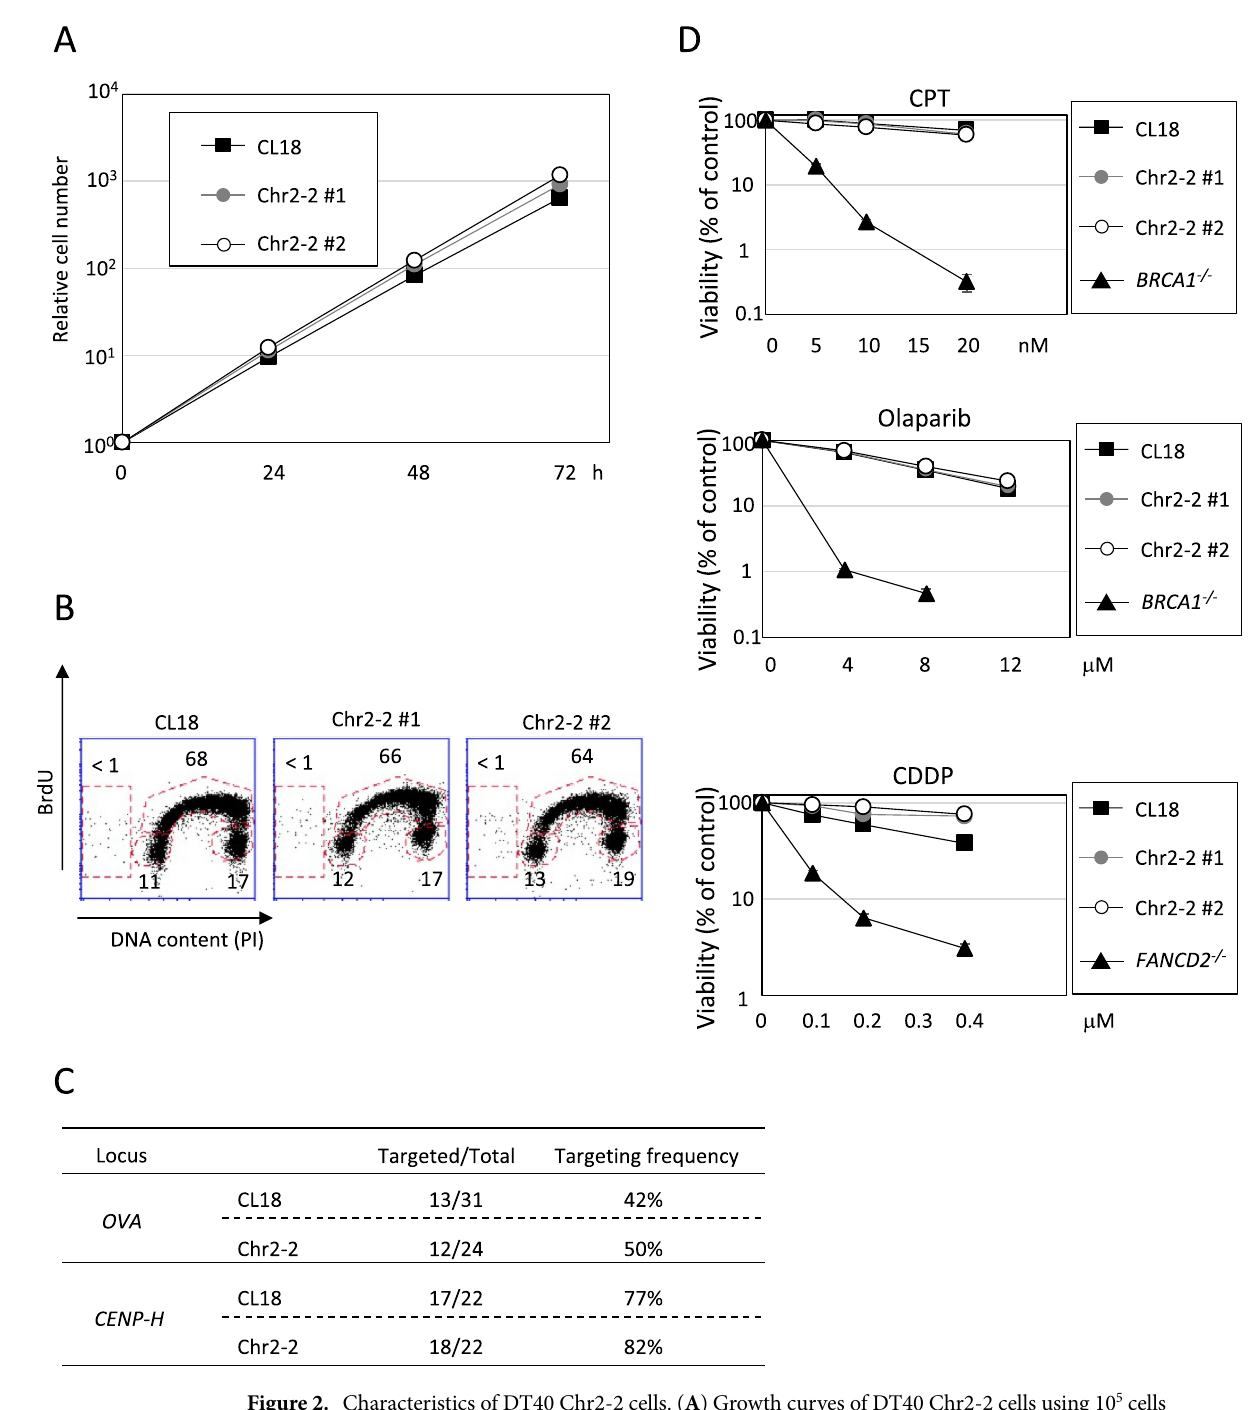
Figure 2. Characteristics of DT40 Chr2-2 cells. ( A ) Growth curves of DT40 Chr2-2 cells using 10 5 cells inoculated in 1 mL of medium. Cell number was counted and passaged every 24 h. ( B ) Cell cycle distribution of DT40 Chr2-2 cells. Cells were pulse-labeled with BrdU for 15 min, harvested, and then incubated with anti- BrdU antibody. The cells were stained with Alexa488-conjugated anti-Mouse IgG co-stained with PI for the detection of DNA content. ( C ) Targeting frequency of DT40 CL18 and Chr2-2 cells. Cells were transfected with targeting constructs of the indicated loci. Targeting frequency was calculated by targeted over analyzed clone numbers. ( D ) Cellular sensitivity against DNA damaging agents. The indicated genotype cells were exposed to CPT (top), Olaparib (middle), or CDDP (bottom). The dose of the genotoxic agent is displayed on the x-axis on a linear scale, while the percent fraction of surviving cells is displayed on the y-axis on a logarithmic scale. Error bars (same size or smaller than the symbols) show the SD of the mean for 3 independent